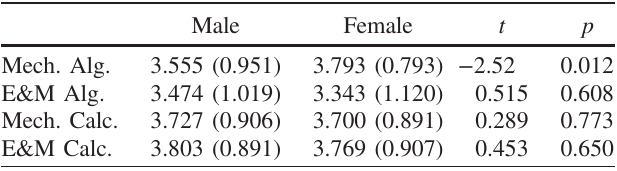
TABLE XI. Average student contribution valuation (and stan- dard deviation) for each course, as well as the t test and significance between these